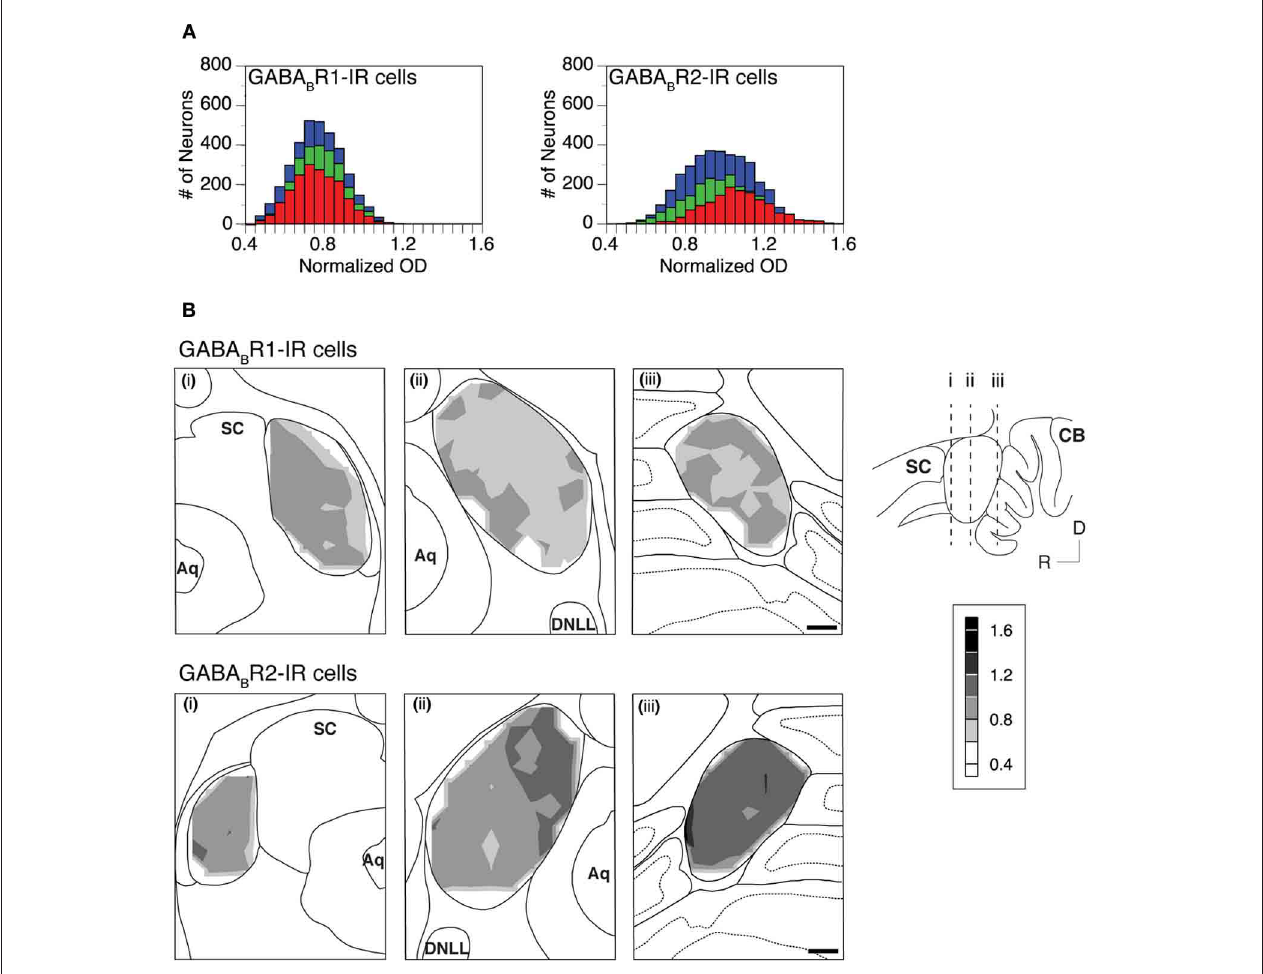
FIGURE 7 | (A) Histograms showing distributions of the normalized OD for individual GABA B R1-IR cell bodies (left panel) and GABA B R2-IR cell bodies (right panel) in the ICc (green), ICd (red), and ICx (blue). Analyses were conducted on two animals for each subunit. Results in the left and right panels are from two different animals. (B) Regional distribution of the mean normalized OD of GABA B R1-IR cells (top panels) and GABA B R2-IR cells